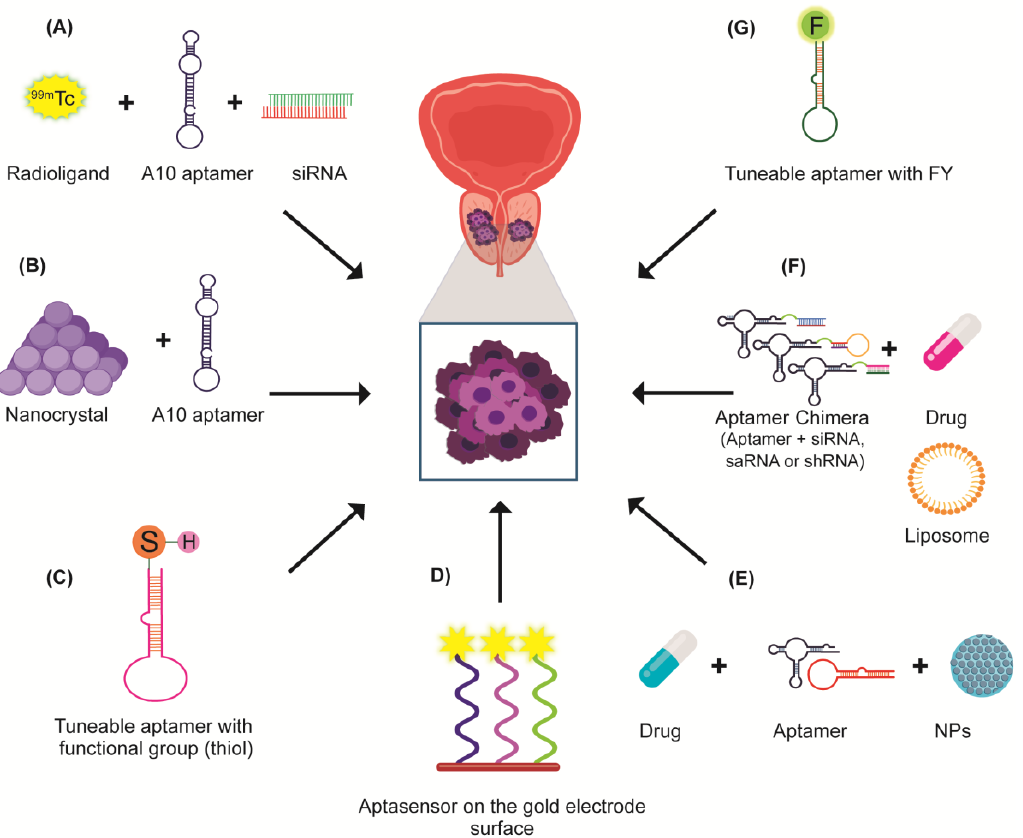
Figure 5. Scheme depicting some applications of aptamers in the diagnosis and treatment of PCa. ( A ) Aptamers can be coupled to radioligands and siRNA to specifically deliver the siRNA in PSMA + cells. The inclusion of the technetium radionuclide ( 99m Tc) allows the use of this aptamer in either therapeutic or diagnostic purposes. ( B ) Aptamers may improve the diagnosis imaging by implement- ing the semiconductor and nanocrystals technology known as quantum dots. ( C ) Aptamers can be modified with thiol groups to give them greater stability. ( D ) Aptamers can be used as aptasensors on gold electrode surfaces to recognize molecular targets. ( E ) Conjugates with aptamers are anchored to nanoparticles for systemic delivery of drugs. ( F ) Aptamers are used in therapy as chimeras apt-siRNA, apt-saRNA, apt-shRNA, apt-drugs, or apt-liposome by directly targeting the tumor. ( G ) Aptamers can be modified with 2′ fluoropyrimidine to increase stability. Current PCa markers such as PSA, PCA3, TMPRSS2-ERG, and PSMA are expressed in PCa cells, but some of them are differently expressed depending on the location even in the same tumor from the same patient, complicating the implementation of a general